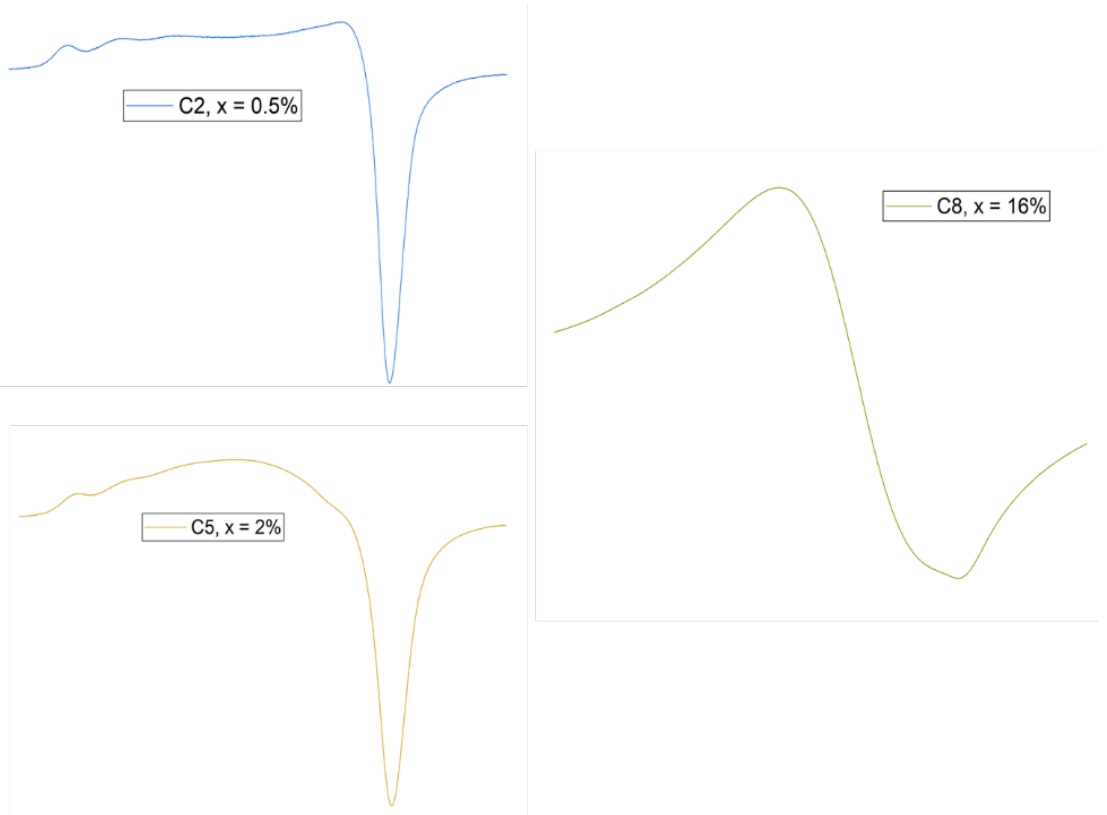
Figure 6. EPR spectra of xCuO · (100 − x) [CaF 2 · 3P 2 O 5 · CaO] glass system with x = 0.5, 2 and 16 mol%.